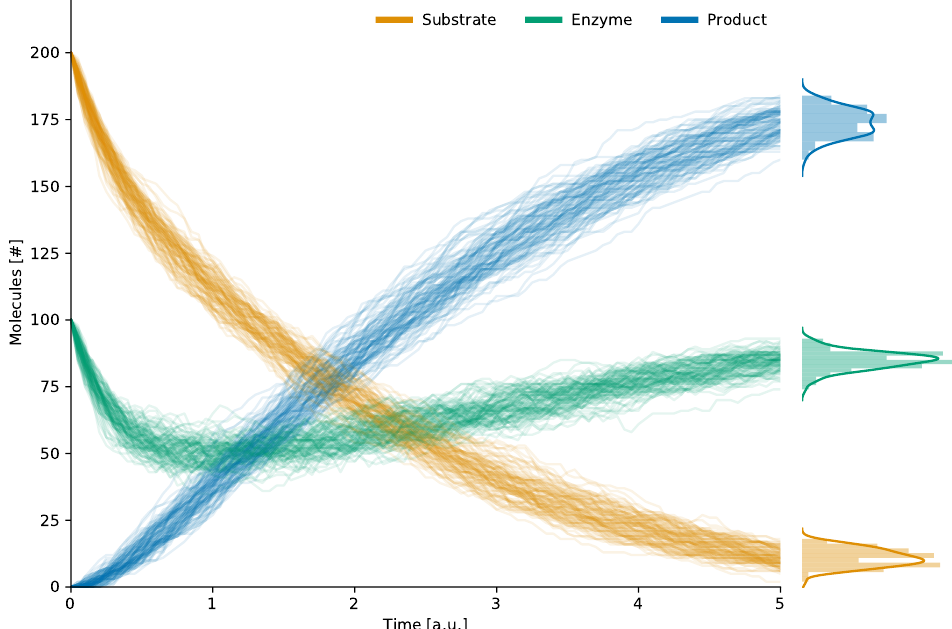
Figure 1. Example of stochastic simulation: 100 independent SSA runs of the MM model—all starting from the same initial state ( S = 200, E = 100, ES = 0, and P = 0) and using the same parameterization—lead to quantitatively different trajectories and a final distributions of the chemi- cal